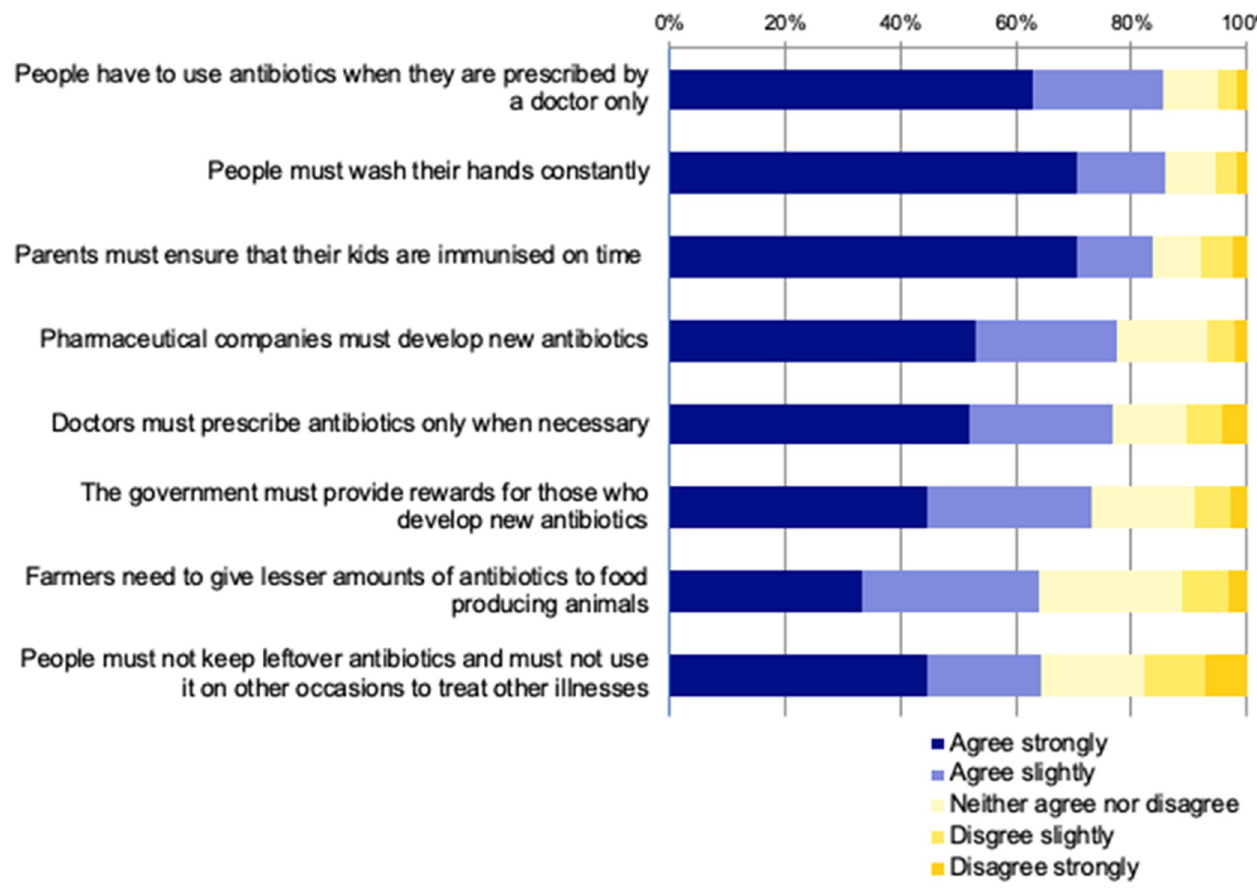
Fig 2. Participants’ attitudes towards how to address the issue of antibiotic resistance.